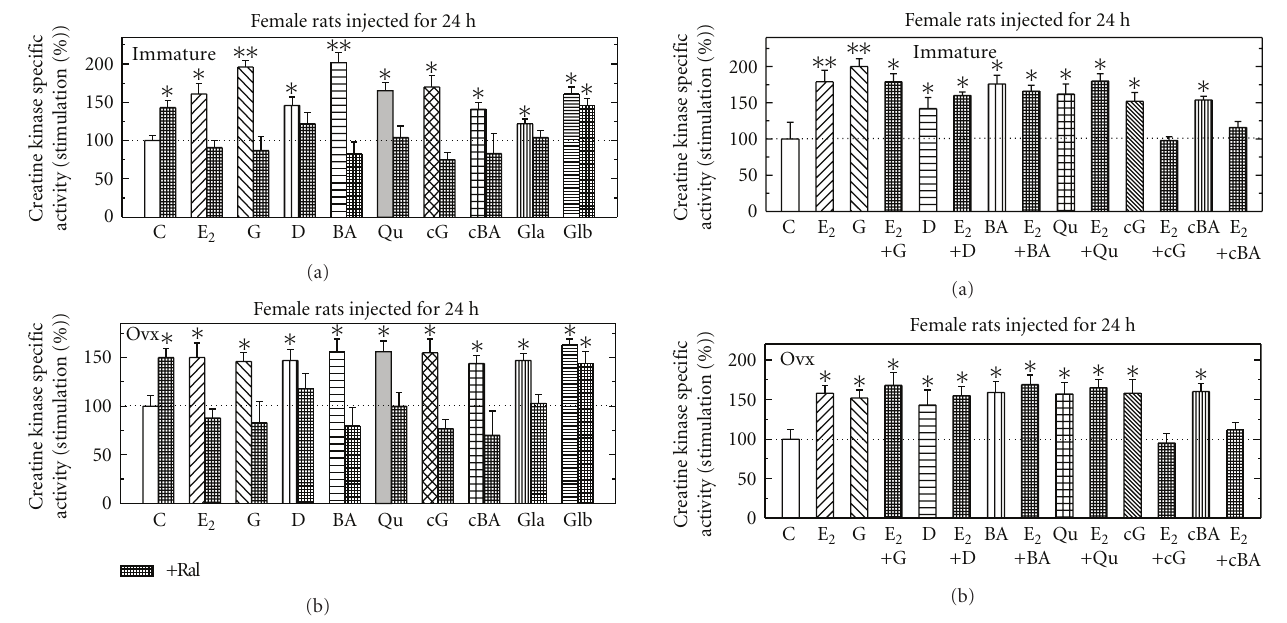
Figure 2: Stimulation of creatine kinase (CK) specific activity by di ff erent estrogenic compounds with and without raloxifene (Ral; cross-hatches bars) in pituitary from immature (a) and from ovariectomized female rats (Ovx; b). Rats were treated and assayed for CK activity as described in Section 2. Results are means ± SEM for n = 5–15 rats/group. Experimental means compared to control means: ∗ P < . 05 and ∗∗ P < . 01. Basal activity in Pi from intact rats was 1 . 22 + 0 . 27 μ mol/min/mg protein and from Ovx was 0 . 67 + 0 . 22 μ mol/min/mg protein.